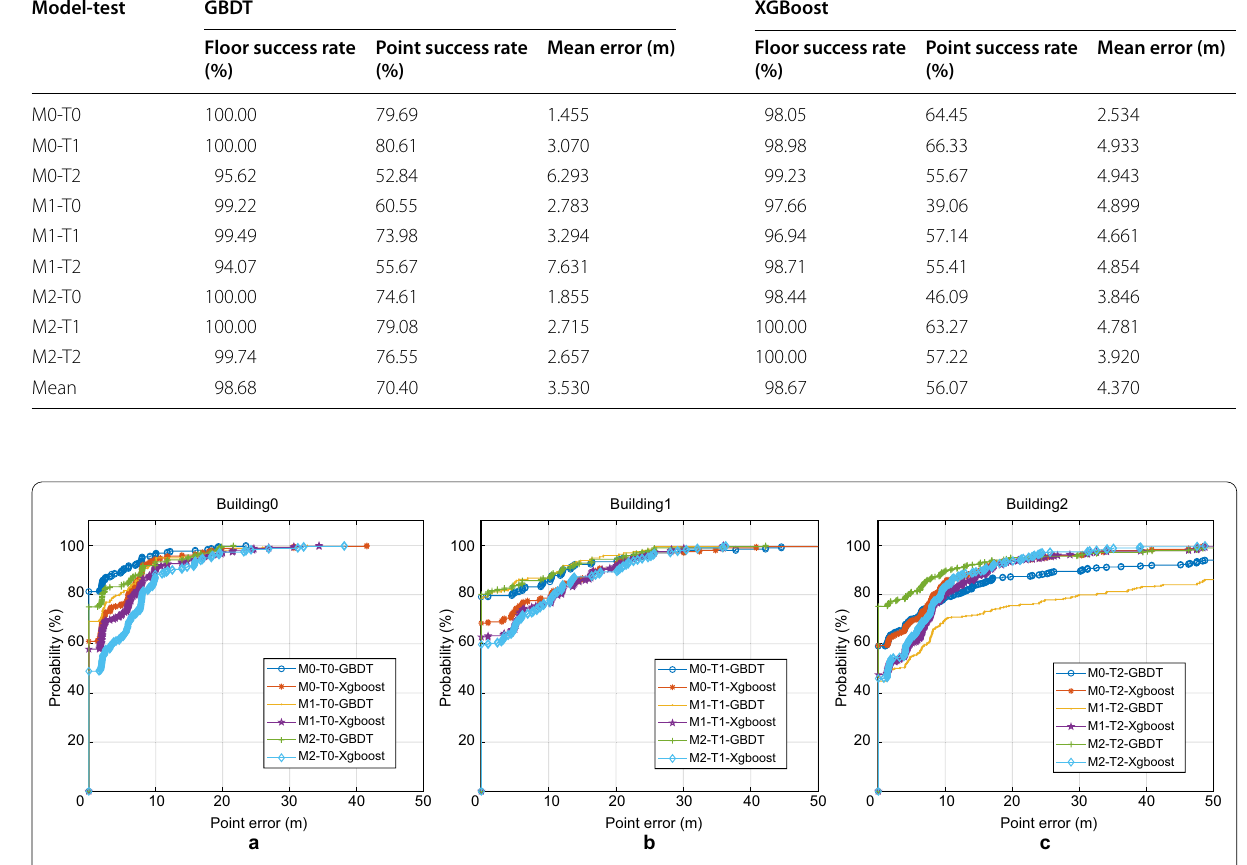
Fig. 13 The CDFs of the proposed method using partial features